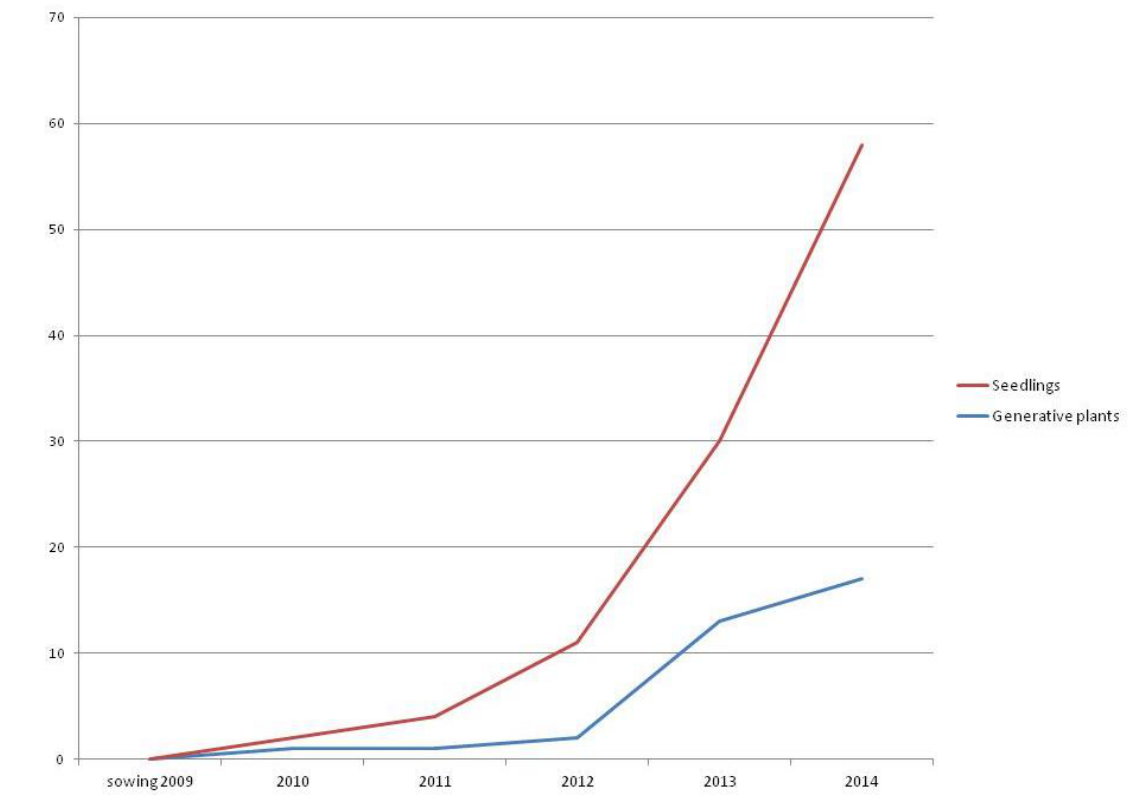
Fig. 13. Characteristics of the Biscutella population on the “Dołki”spoil heap in Piekary Śląskie: A – number of seedlings; B – number of generative plants